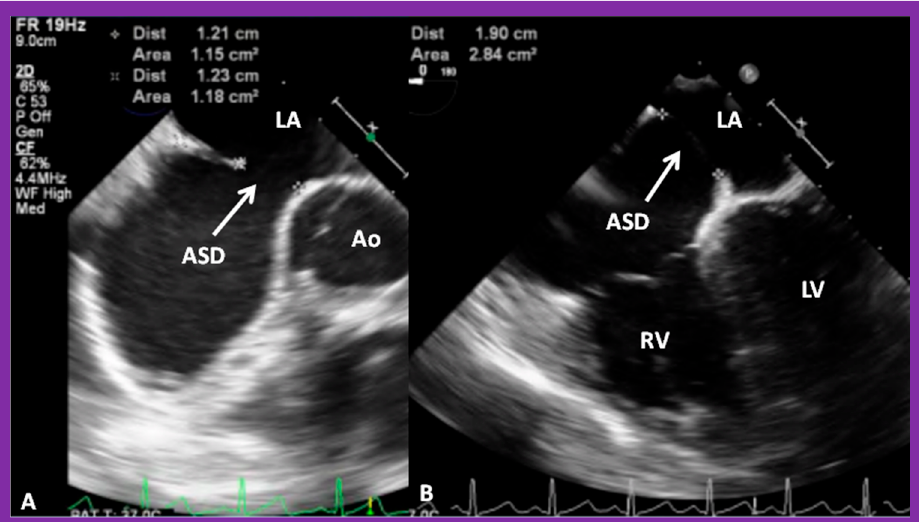
Figure 16. Transesophageal echocardiographic (TEE) study of the atrial septum in short-axis ( A ) and four-chamber ( B ) views demonstrating an atrial septal defect (ASD). Small retro-aortic and mitral rims are seen. Ao, aorta; LA, left atrium; LV, left ventricle; RV, right ventricle.